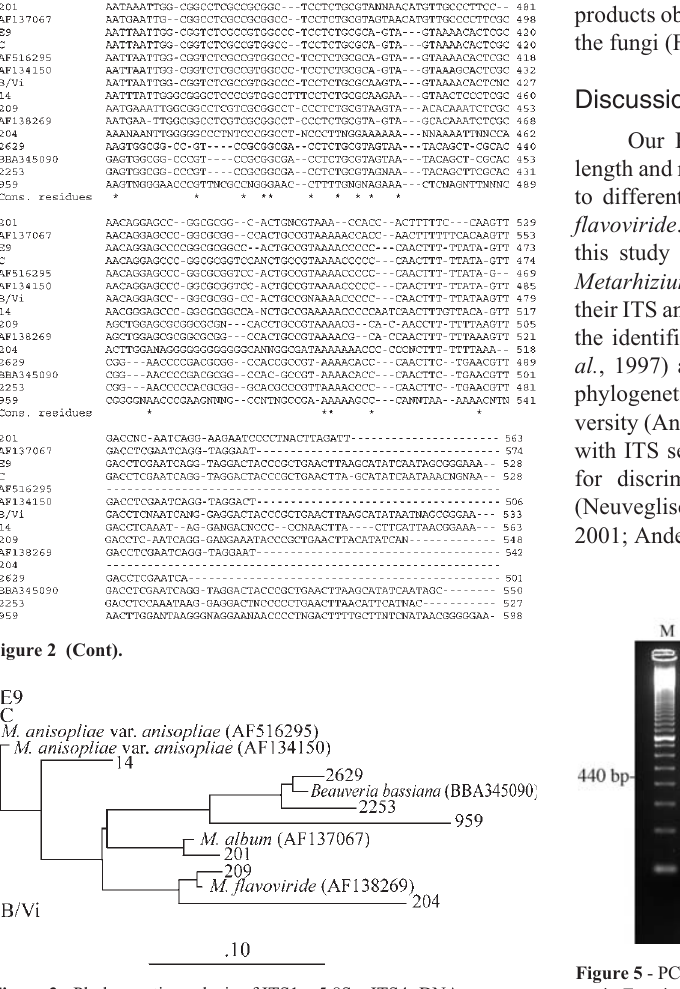
Figure 3 - Phylogenetic analysis of ITS1 – 5.8S – ITS4 rDNA sequences from Metarhizium anisopliae , Metarhizium album , Metarhizium flavoviride and Beauveria bassiana strains based on the Neighbor-joining method. GenBank accession numbers are listed after species names.